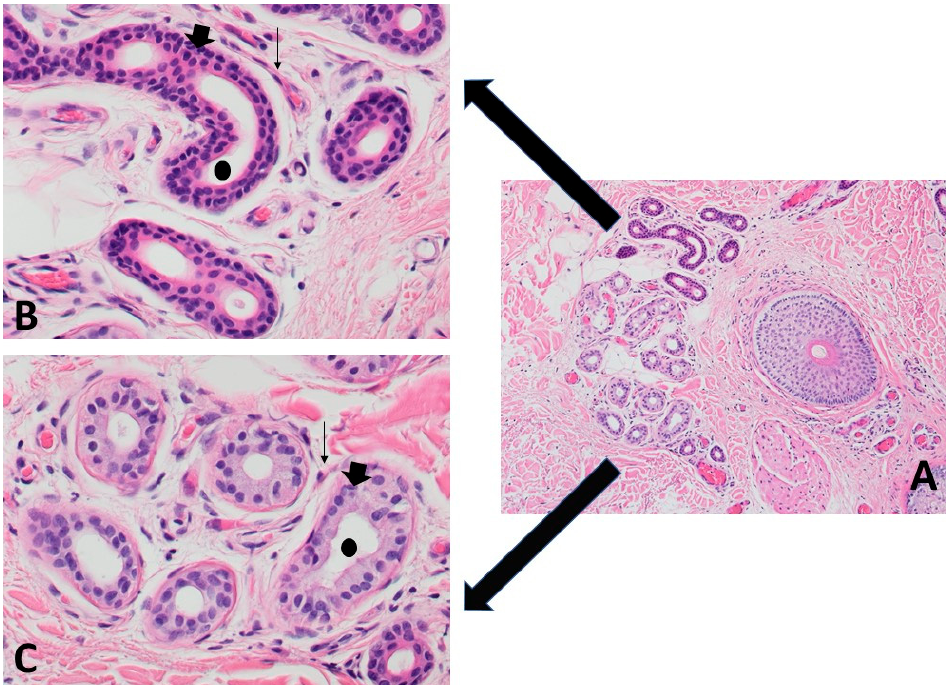
Figure 2. Skin specimen section: ( A ) skin specimen with hair follicle, apocrine and eccrine gland surrounded by connective tissue (40×, HE), ( B ) eccrine glands secrete a fluid directly onto the skin surface, thin arrow—myoepithelial cells, thick arrow—eccrine gland cells, circle—lumen (200×, HE), ( C ) apocrine glands produce a smelling, viscous fluid into the hair follicle, thin arrow—myoepithelial cells, thick arrow—apocrine gland cells, circle—lumen (200×, HE). Int. J. Mol. Sci. 2021 , 22 , x FOR PEER REVIEW